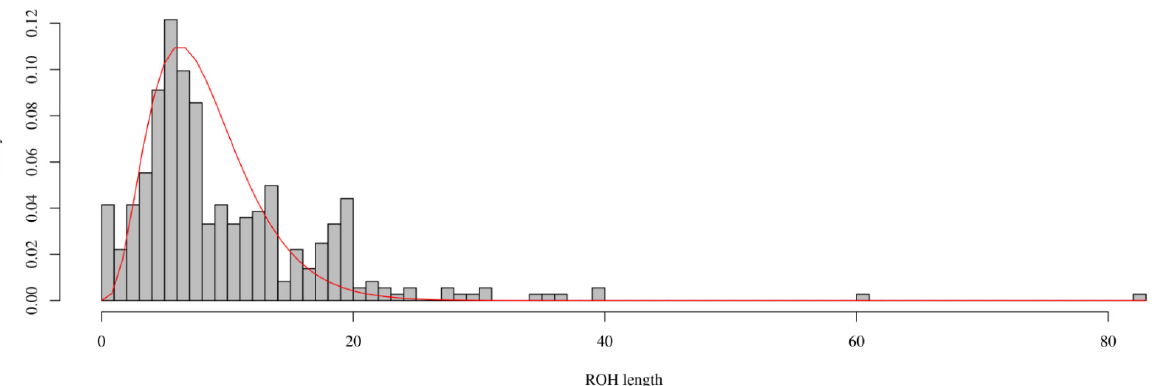
Figure 4. The distribution of ROH hotspot haplotype length in the KIT gene. The x axis is the length of ROH in units of 100 kbp. The red curve indicates the density function for a chi-squared distribu- tion with parameter of degrees of freedom of 8.2 fitted to the distribution of lengths of ROH.